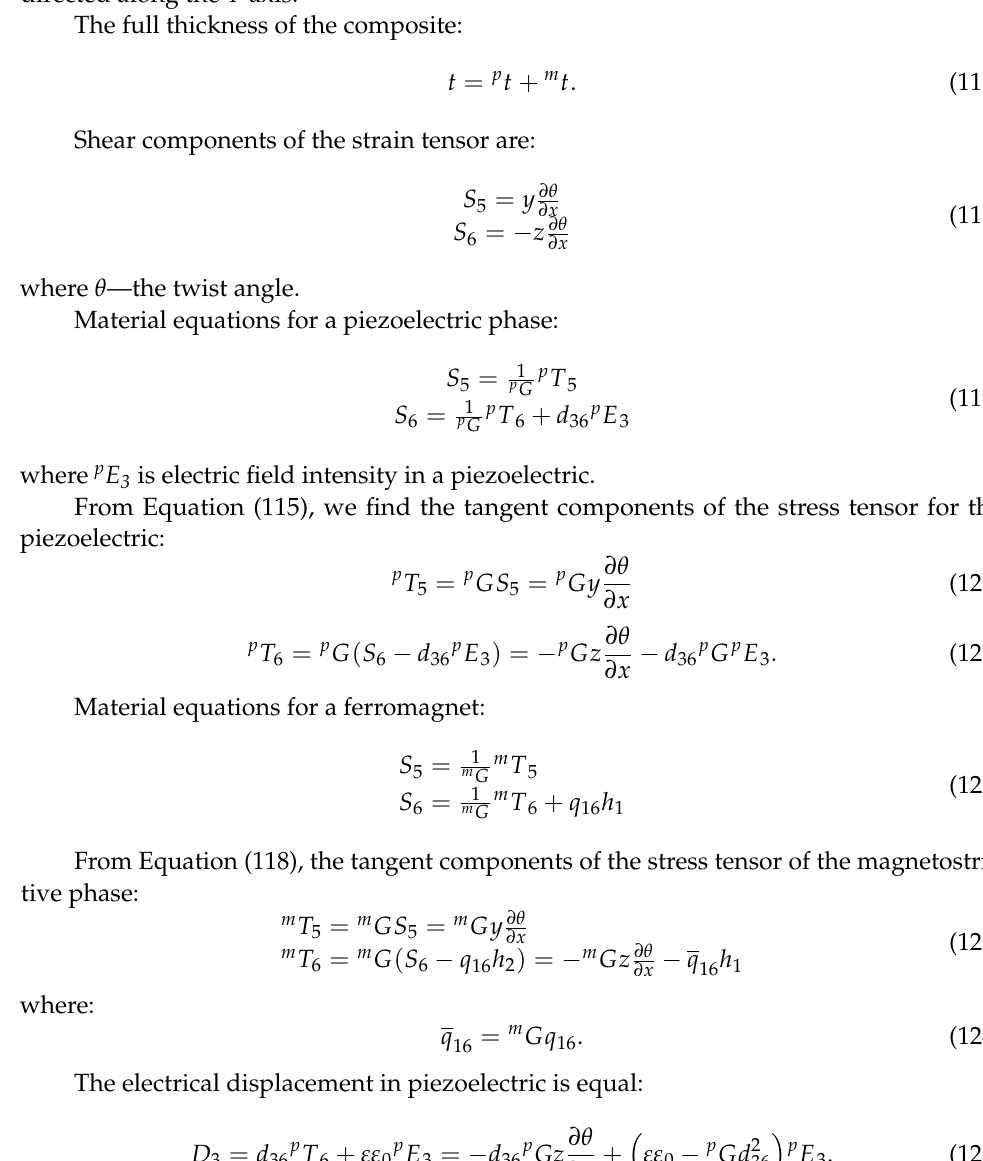
Figure 14. Asymmetric two-layer magnetoelectric composite for calculation of torsional mode. The AC magnetic field is directed along the X axis, and the DC magnetic field is directed along the Y axis.